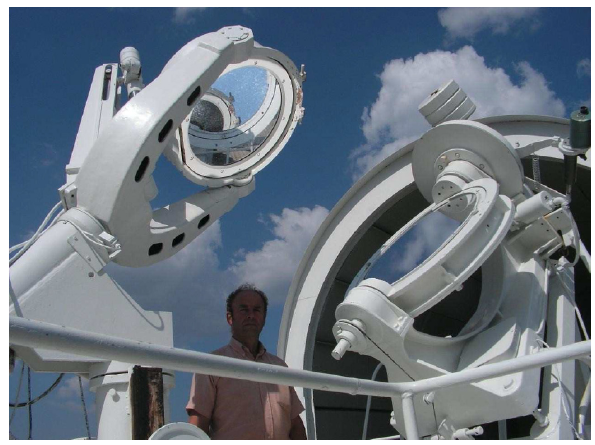
Figure 1. Coelostat of the Tower Solar Telescope